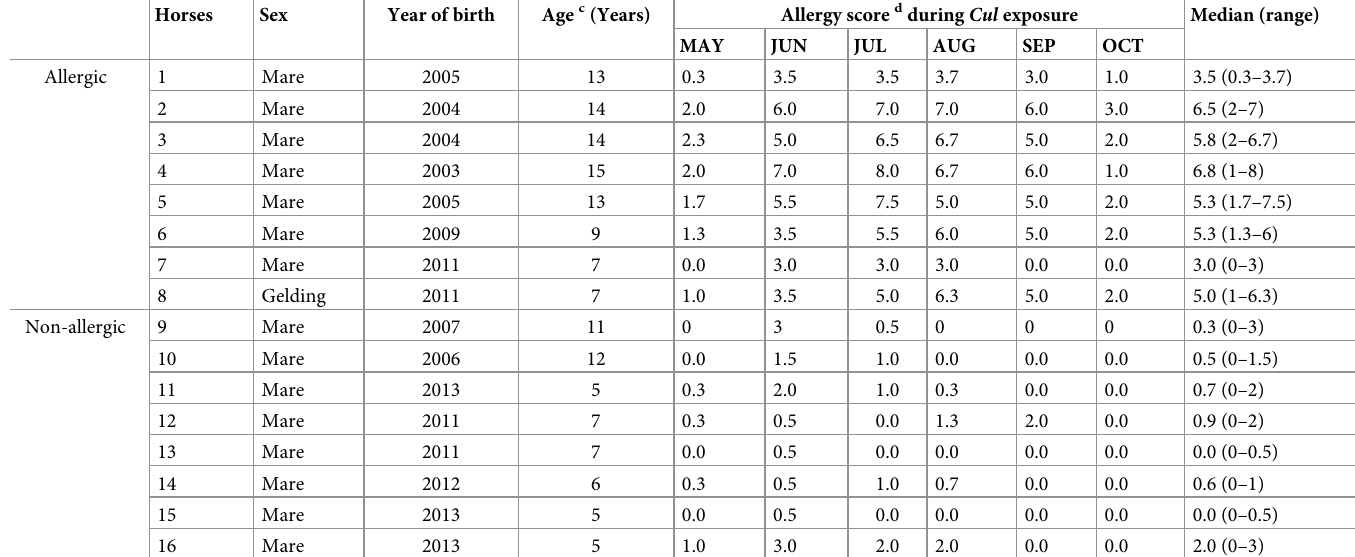
Table 1. Clinical allergy scores a of study groups during natural exposure to Culicoides (Cul) midges in the environment (mid-May to mid-October) b .